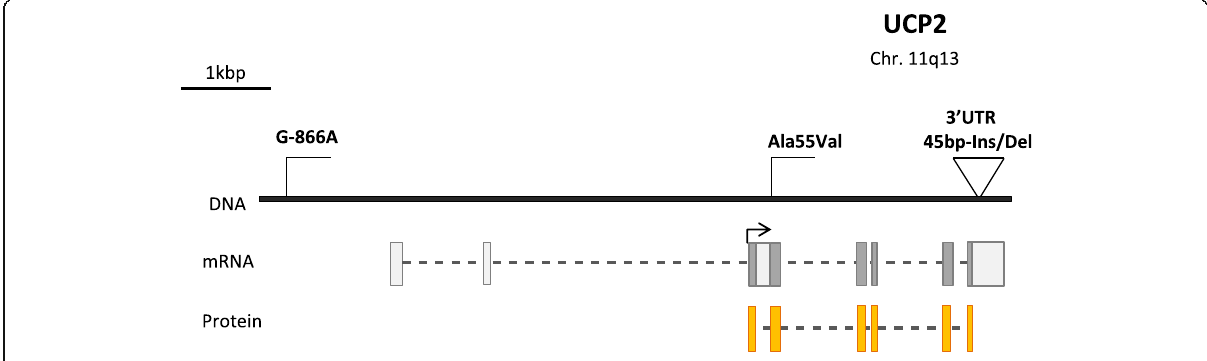
Fig. 3 Schematic structure of the Ucp2 gene and its best-studied